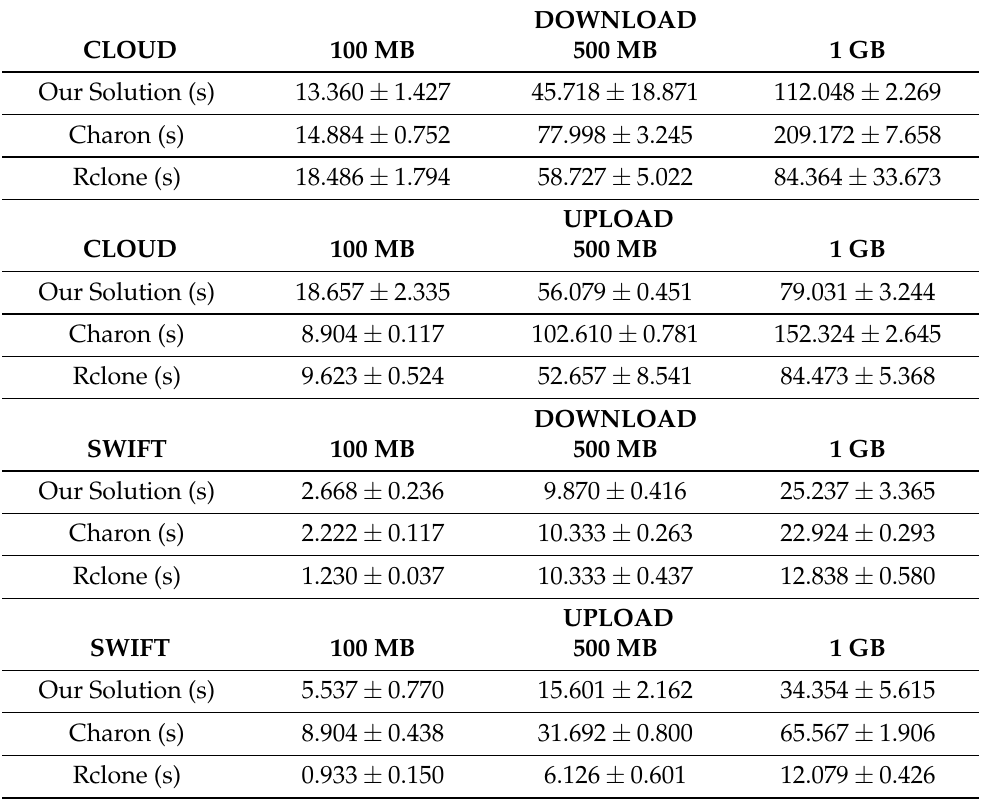
Table 5. Off-premise data offload performance when compared with Charon and rClone, in seconds.